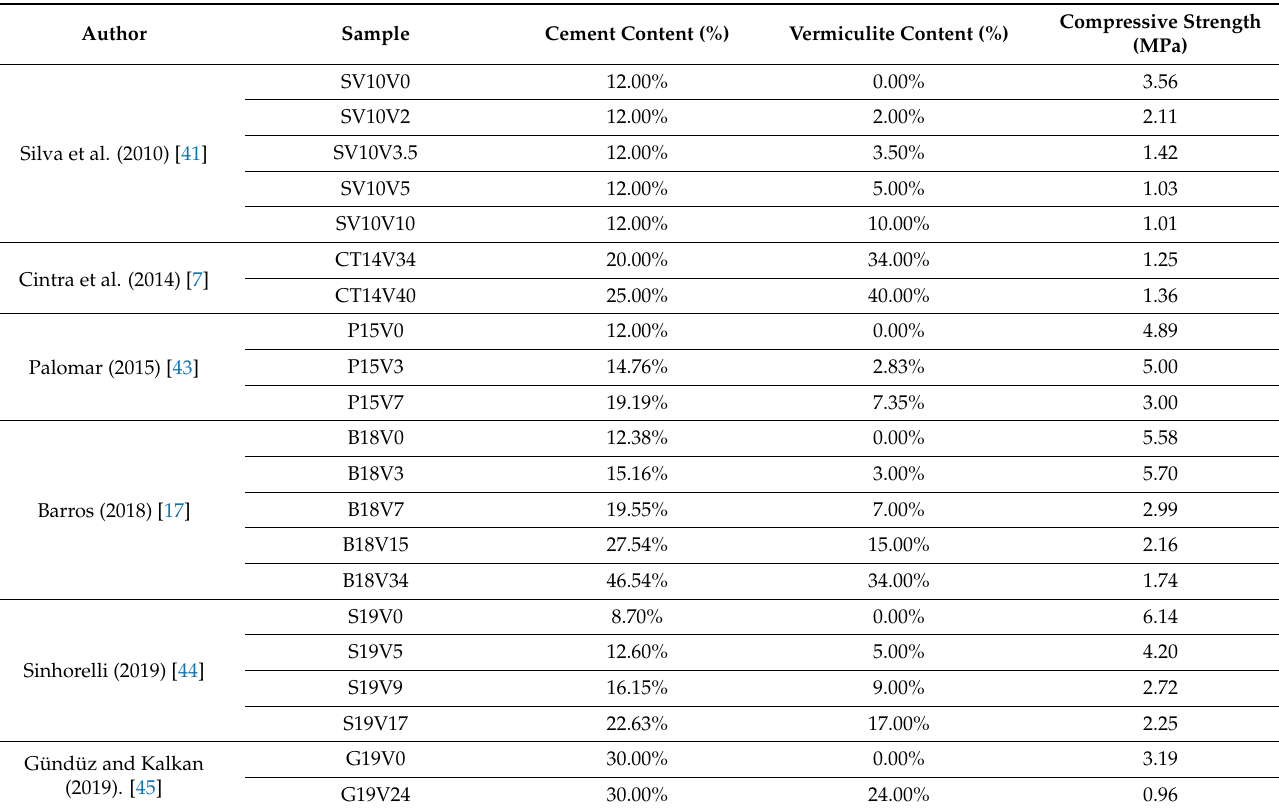
Table 10. Values of compressive strength and cement and vermiculite content in the articles studied [7,17,41,43–45].